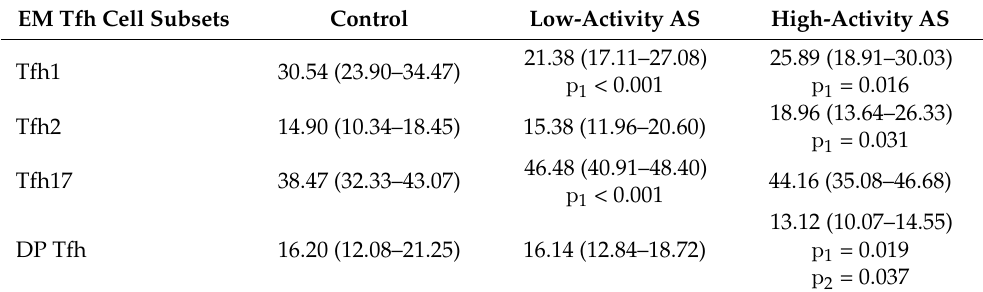
Table 7. Peripheral blood EM Tfh-cell subset composition (%) in activity-driven AS ( Ме (C 25 –C 75